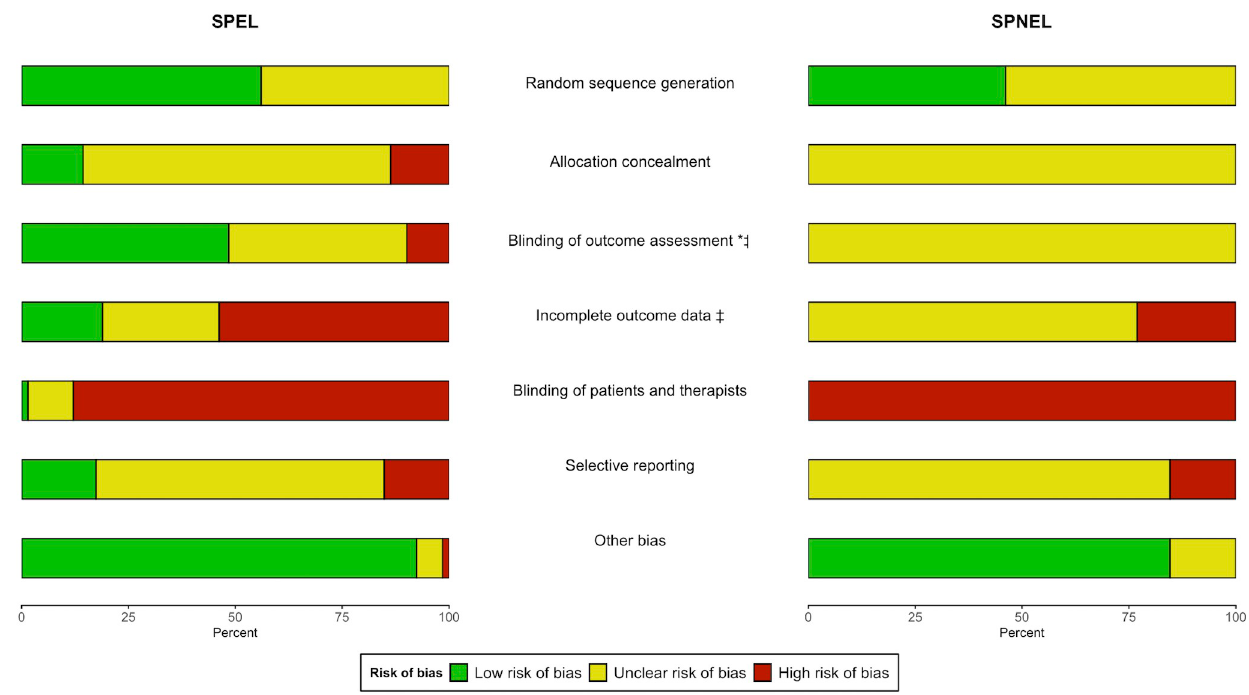
Fig 2. Comparison of risk of bias between SPEL and SPNEL. � Significant difference (p � 0.05) for the quality of studies (low risk versus both unclear and high risks); ‡ Significant difference (p � 0.05) for the quality of reporting (amount of unclear risk).